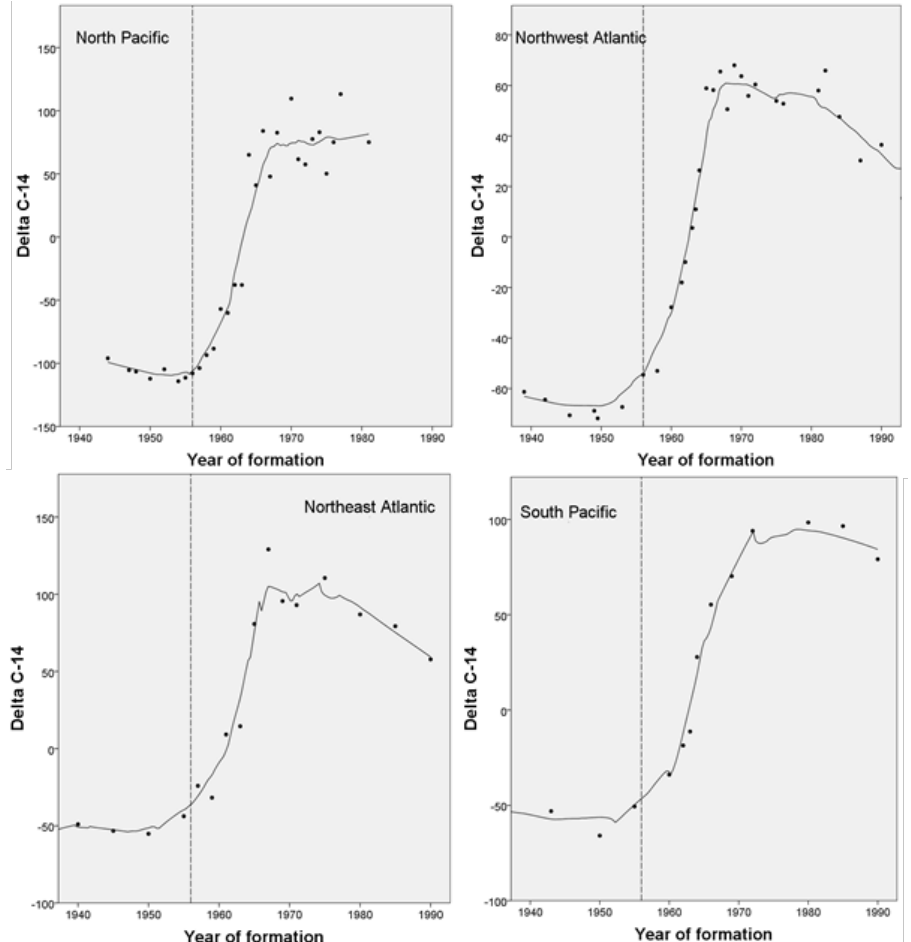
Fig. 1. A common characteristic of bomb radiocarbon chronologies from all over the world is the nearly synchronous increase from background levels around 1956 (vertical line). Thus the year of initial increase in radiocarbon serves as a dated marker in all growth band sequences. In contrast, the asymptotic (post-bomb) radiocarbon level can vary widely among water bodies due to differences in water mixing (= dilution) rate, and thus is not particularly useful as a marker. Fitted line represents LOESS